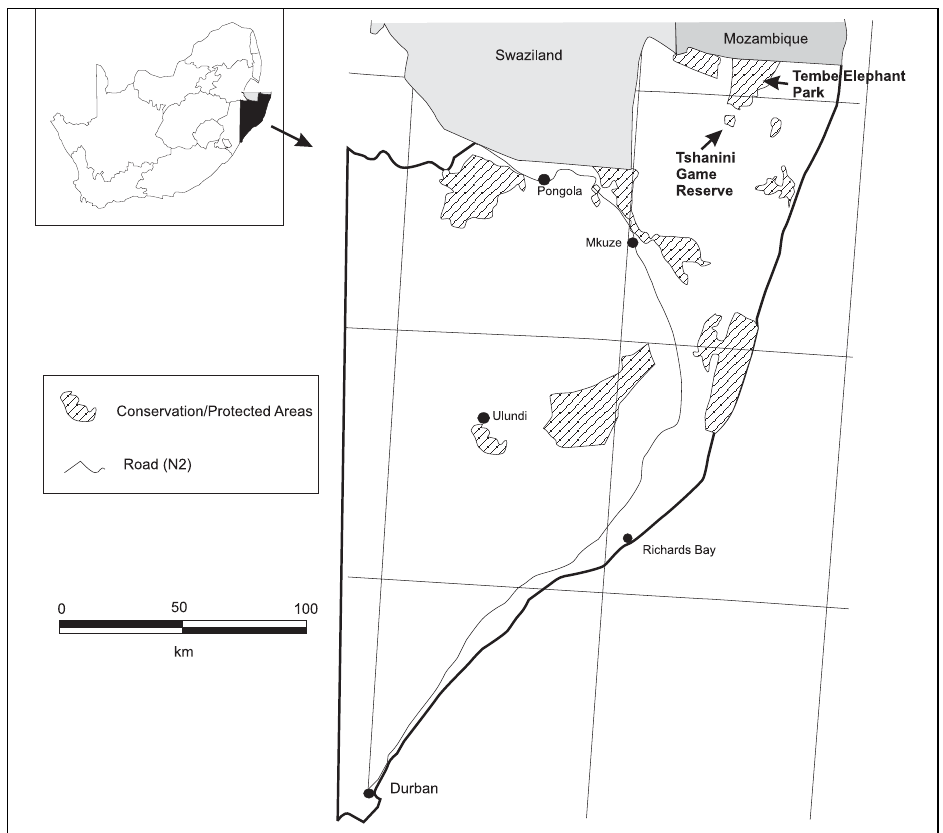
Fig. 1. Map of Maputaland with the locations of Tembe Elephant Park and Tshanini Game Reserve in northern KwaZulu-Natal, South